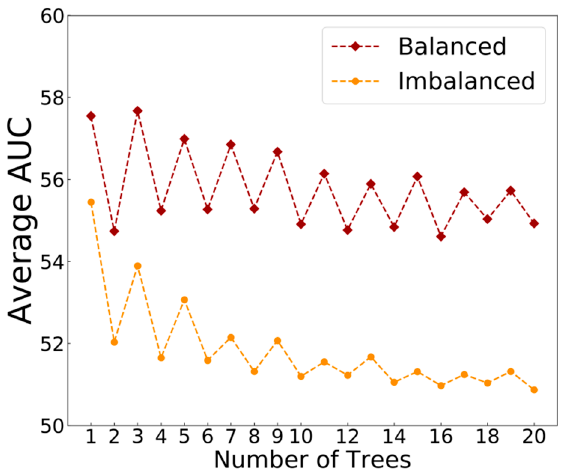
Figure 5. Average AUC when the value of N is changed in RF classification on imbalanced and balanced data.